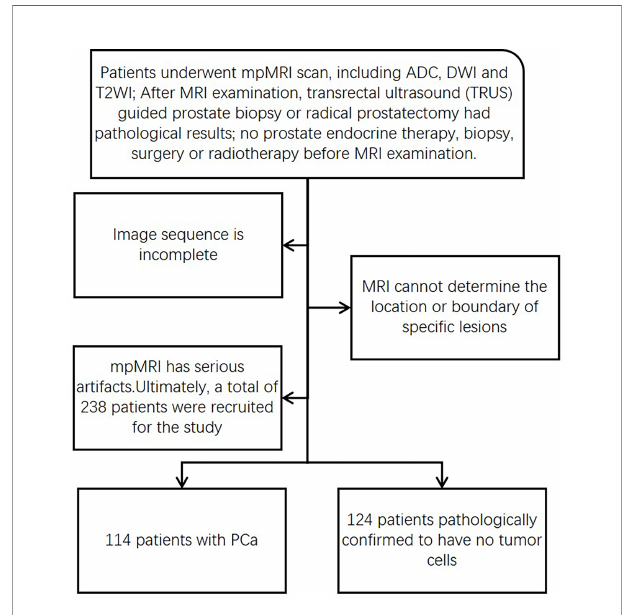
FIGURE 1 | Flowchart of patient recruitment and